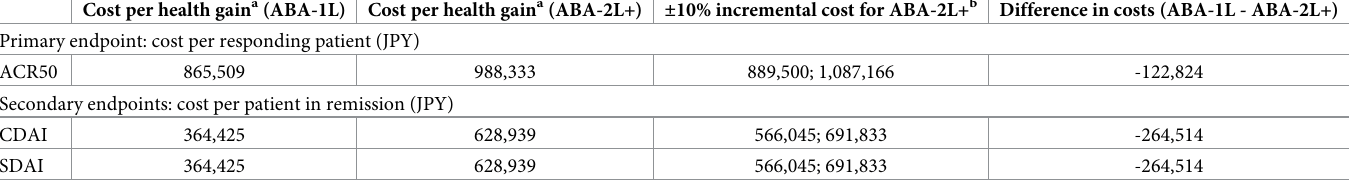
Table 9. Cost per responder and patient in remission–per member per month (ABA-1L vs.